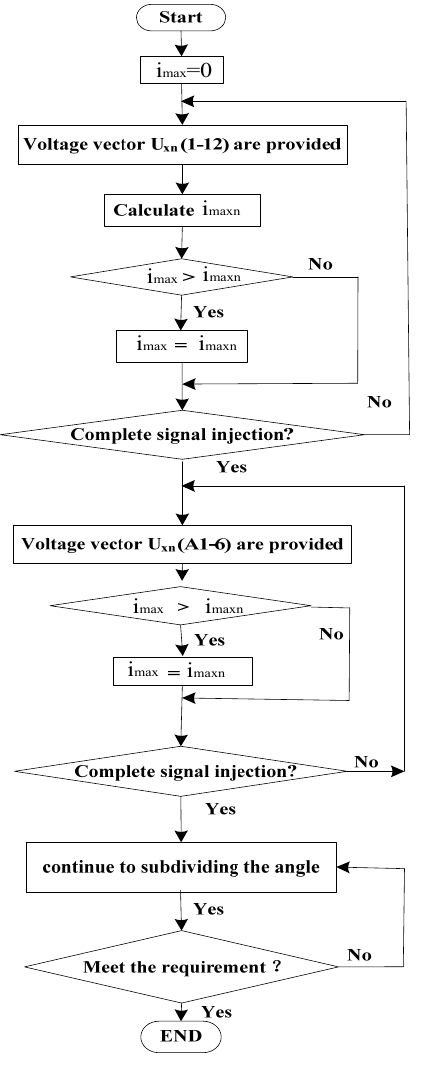
Figure 6. Flow chart of the initial rotor position estimation.